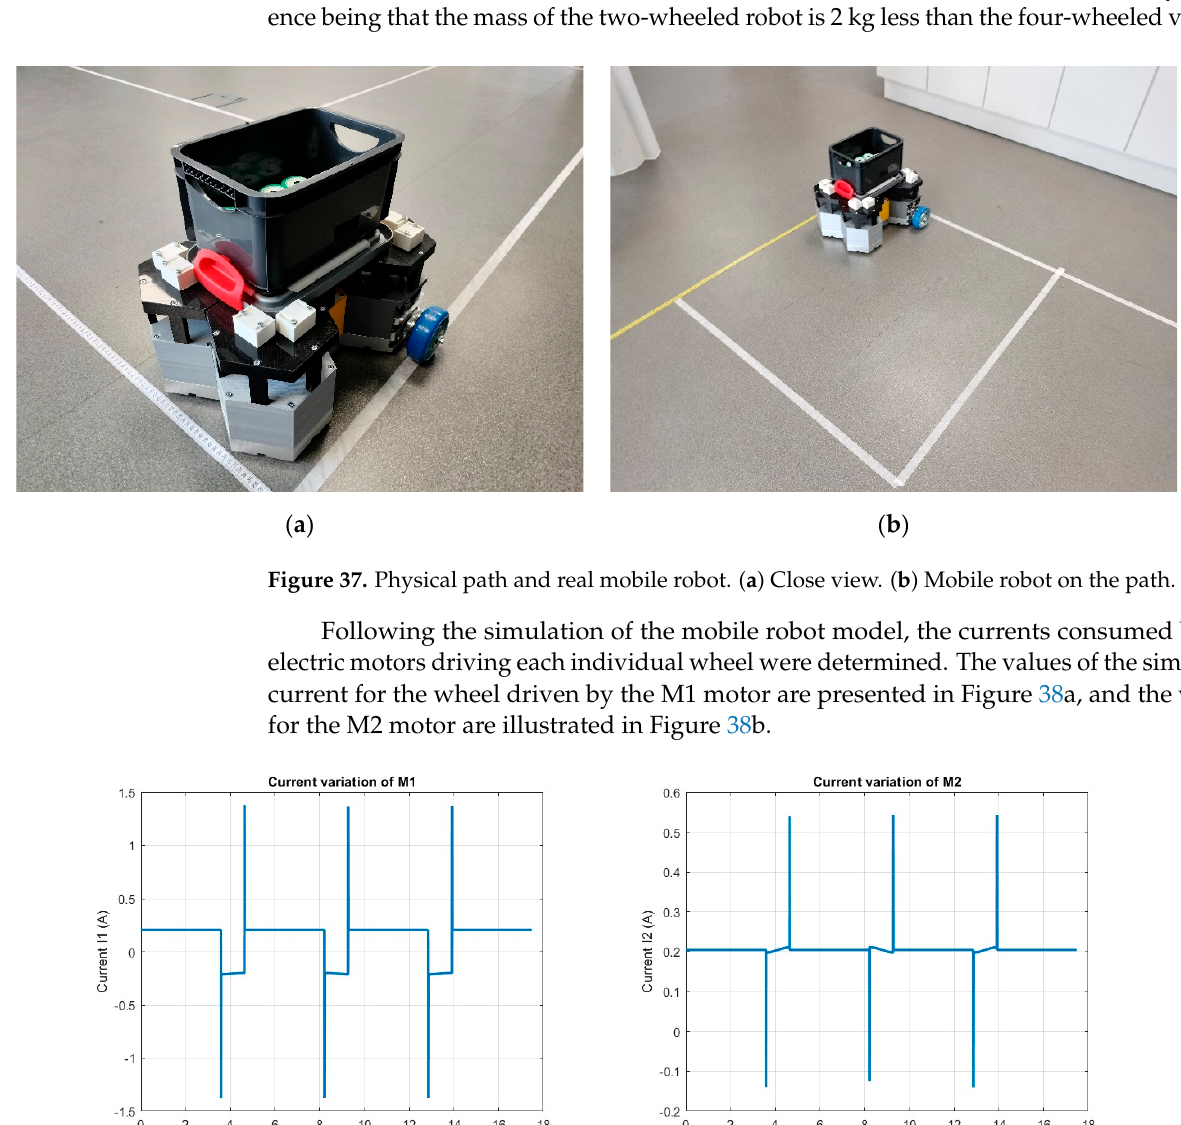
( b ) Figure 39. Current variation measured using the functional model for moving on the prede fi ned path. ( a ) Wheel 1. ( b ) Wheel 2. In Figure 40, the current diagrams obtained from the simulation of the mobile robot model and using experimental tests for both servomotors M1 and M2 are presented in comparison.